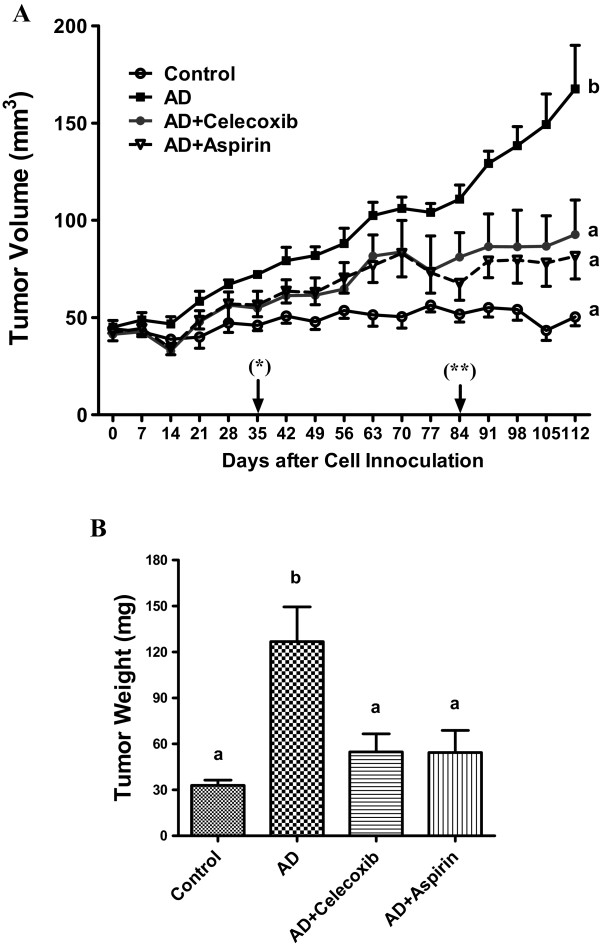
Effect of celecoxib and aspirin on the growth of MCF-7aro xenograft. Mice were inoculated with MCF-7aro cells at 2 sites per mouse after ovariectomy. They were injected subcutaneously with androstenedione every day starting on the next day after inoculation. Tumor volumes (A) were estimated once a week from Day 7 after inoculation. Day labeled as (*) was the time when AD Group significantly deviated from Control Group sacrifice. (**) was the day when tumor volumes of AD+Celecoxib and AD+Aspirin started deviated from that of AD. The tumor weight was measured at the day of sacrifice (B). Groups labeled as AD, AD+celecoxib, and AD+aspirin are the mice treated with androstenedione, androstenedione and celecoxib, and androstenedione and aspirin, respectively. Values are means ± SEM, n=6 to 8 (2 inoculation sites combined as one data point). The data was analyzed by One-way ANOVA, followed by Tukey’s Multiple Comparison test when P<0.05. Means labeled with different letters are significantly different (order: b>a).